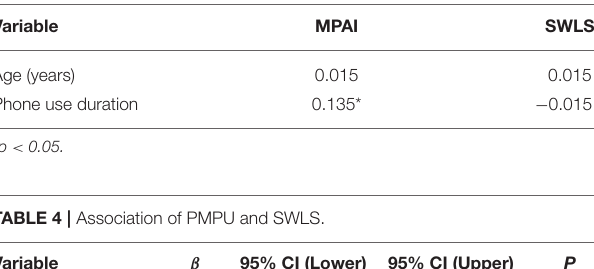
TABLE 3 | Pearson correlation analysis for PMPU and SWLS.